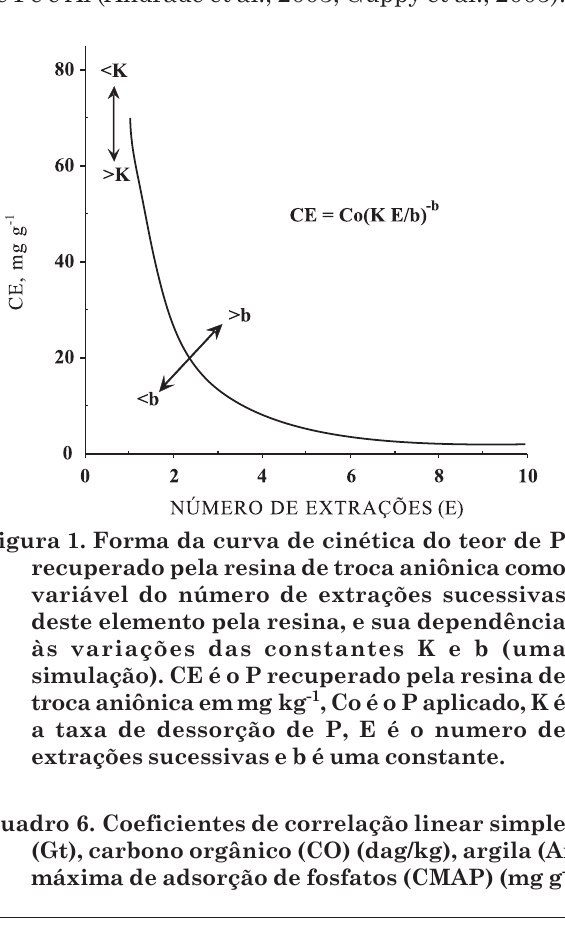
:HClO (8:3, v/v)). ns, ** e ***: não significativo e significativo a 1 e de 0,1 %, 3 4